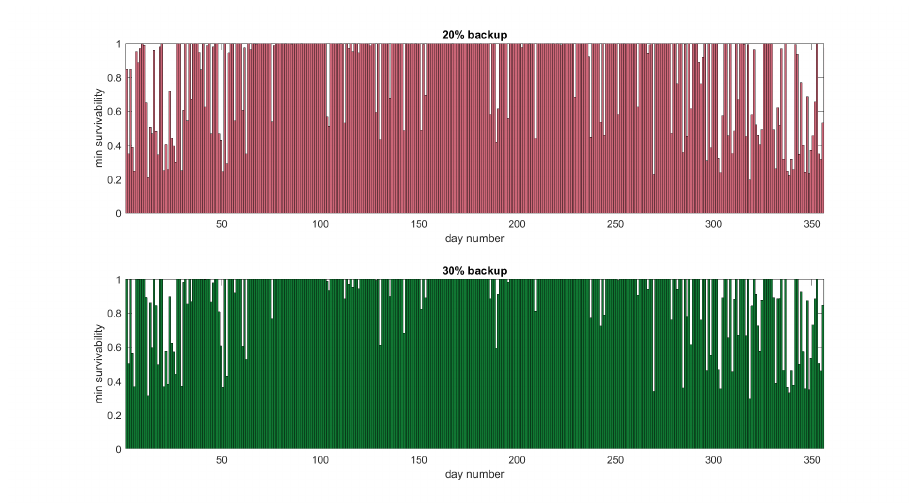
Figure 6. Minimum survivability per day for a full year with the power-save strategy for 20% and 30% backup capacity, respectively.